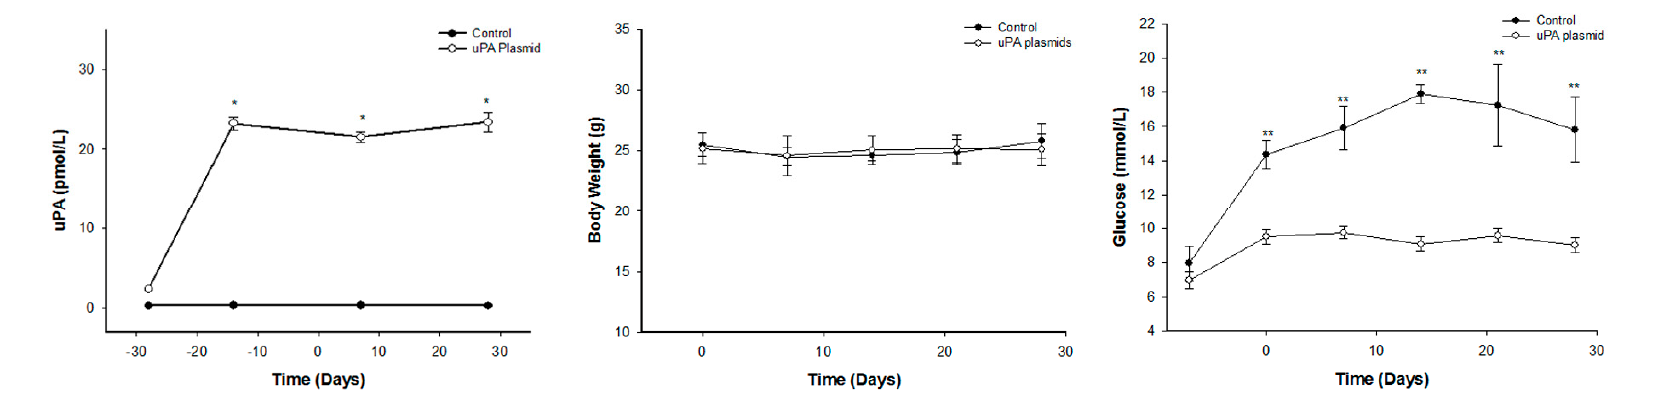
Figure 3. Changes in uPA, body weight, and blood glucose in uPA- / - mice treated with uPA plasmids. The uPA- / - mice were treated with intramuscular injection of uPA plasmids (blank circle) or control plasmid (black circle) weekly. The uPA, body weight, and blood glucose were measured (n = 6). ( A ) The uPA levels significantly increased after treatment with uPA plasmid in uPA- / - mice. (* p < 0.05) ( B ) Body weight during the whole experiment showed no significant change in the two groups. ( C ) Blood sugar did not elevate after induction, but mice injected with control plasmid developed hyperglycemia. In other words, no uPA- / - mouse developed T2DM after treatment with uPA plasmids (Mann–Whitney U test).